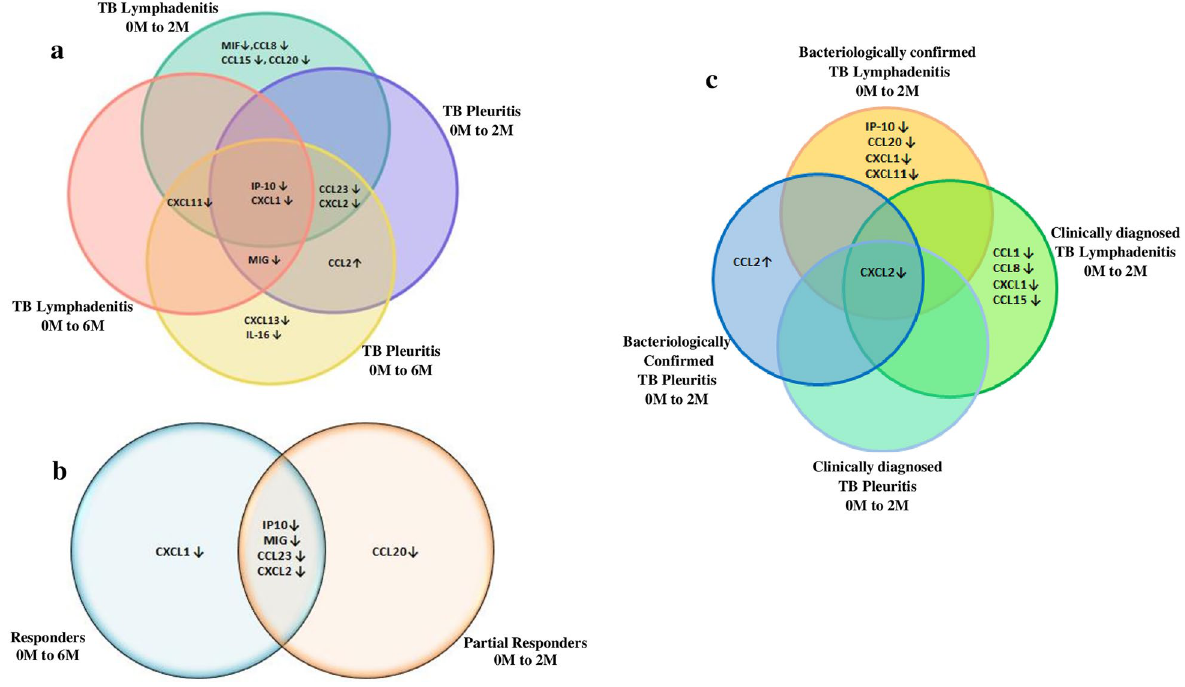
Figure 5. Common inflammatory biomarkers changing significantly with treatment amongst the Tuberculous (TB) lymphadenitis and TB pleuritis patients. ( a ) At the 2nd and 6th months of treatment compared to the baseline values among all TB lymphadenitis and TB pleuritis patients. ( b ) At the 2nd month of treatment compared to the baseline values among the responders and partial responders. ( c ) At the 2nd month of treatment compared to the baseline values among the bacteriologically confirmed and clinically confirmed cases. 0 M to 2 M: biomarkers changing significantly at 2 months as compared to the baseline:0 M to 6 M: biomarkers changing significantly at 6 months as compared to the baseline, ↓ : show a decline in the level of biomarker and ↑ : show an increase in the level of biomarker.